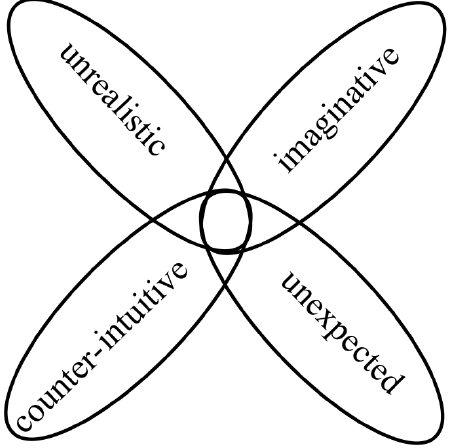
Fig. 2. Utopian ideas include imaginative, unexpected, counter-intuitive and unrealistic at-